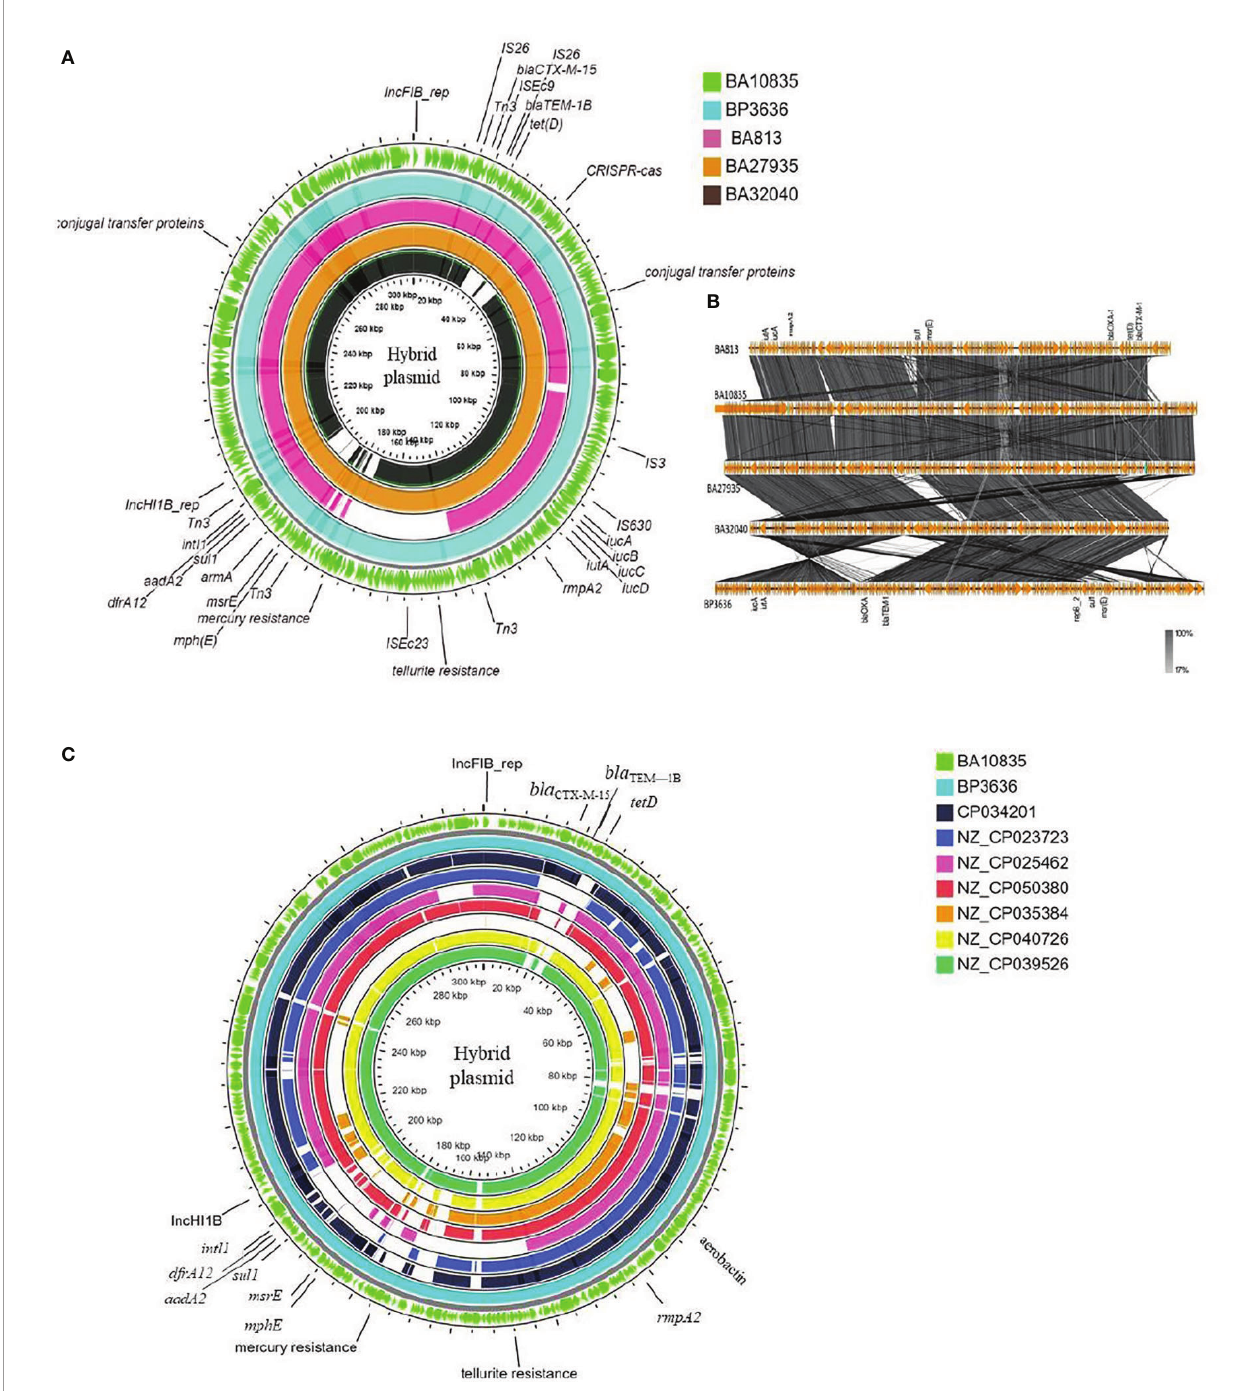
FIGURE 3 | Maps of ST2096 mosaic plasmids in comparison to previously reported IncHI1B-IncFIB virulence plasmids. (A) Circular genome comparison map of IncFIB – IncHIB mosaic plasmids from outer to inner rings-BA10835 (light green), BP3636 (teal), BA813 (red), BA27935 (orange), and BA32040 (black). All the isolates belong to ST2096 and mosaic plasmid from BA813 (MK649825) was isolated during 2017 from the same study center. It lacks the heavy metal resistance encoding region when compared to other plasmids that were isolated during 2019. (B) Linear alignment of the mosaic plasmids obtained K. pneumoniae ST2096 using Easy fi g. (C) Circular genome comparison map of IncHI1B – IncFIB mosaic plasmids from outer to inner rings-BA10835 (light green), BP3636 (teal), CP034201 (navy blue), NZ_CP023723 (indigo), NZ_CP025462 (pink), NZ_CP050380 (red), NZ_CP035384 (orange), NZ_CP040726 (yellow), and NZ_CP039526 (dark green). NZ_CP035384 shows the least similarity to the plasmids from the present study. Details of resistance and virulence genes carried by these plasmids are detailed in Supplementary Table 1